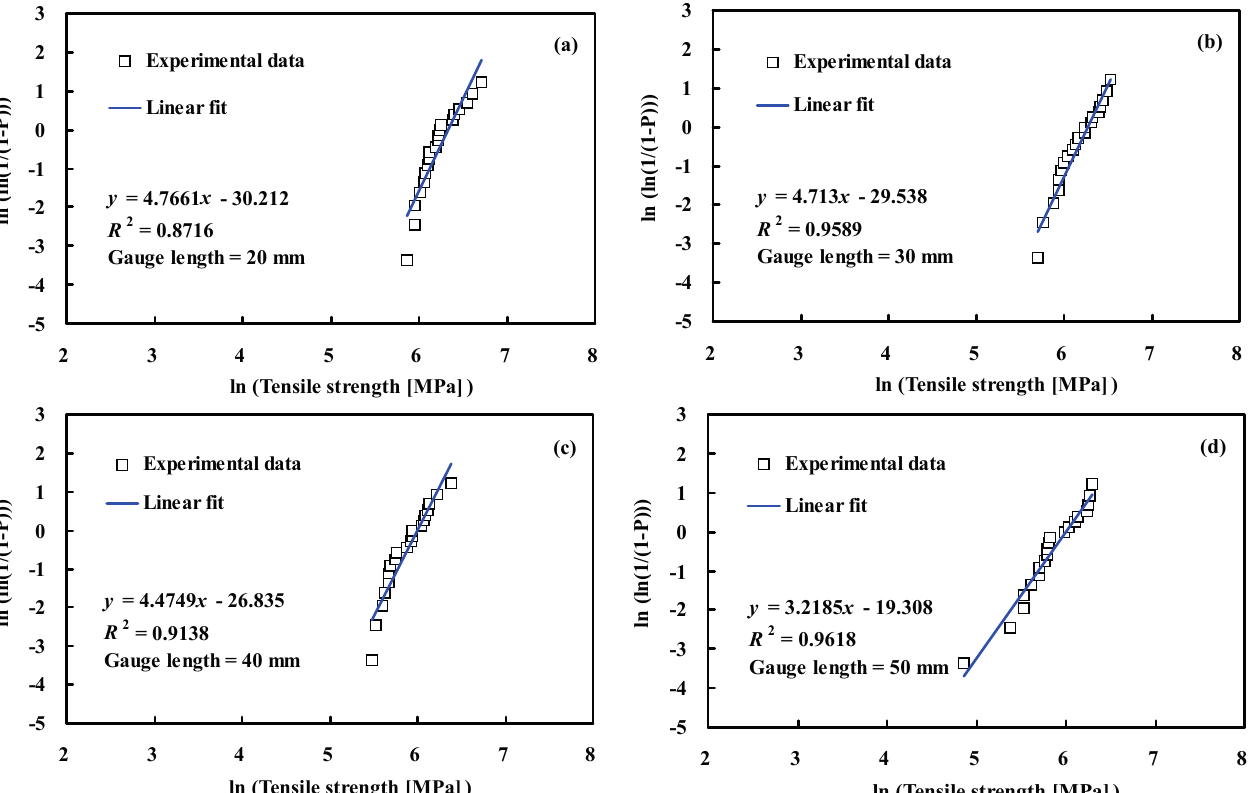
Figure 3. Weibull plots for different gauge lengths of bamboo fiber: ( a ) 20-mm length; ( b ) 30-mm length; ( c ) 40-mm length; and ( d ) 50-mm